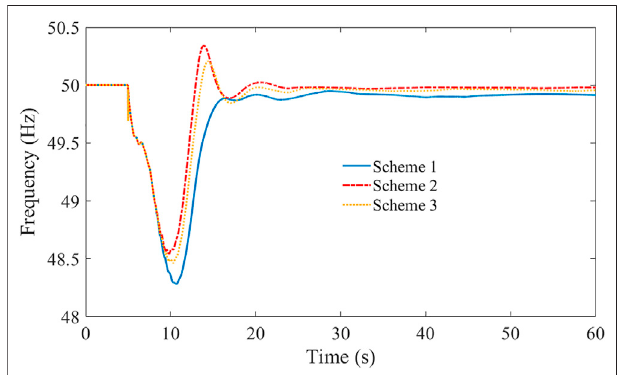
FIGURE 11 | Comparison of different UFLS schemes.